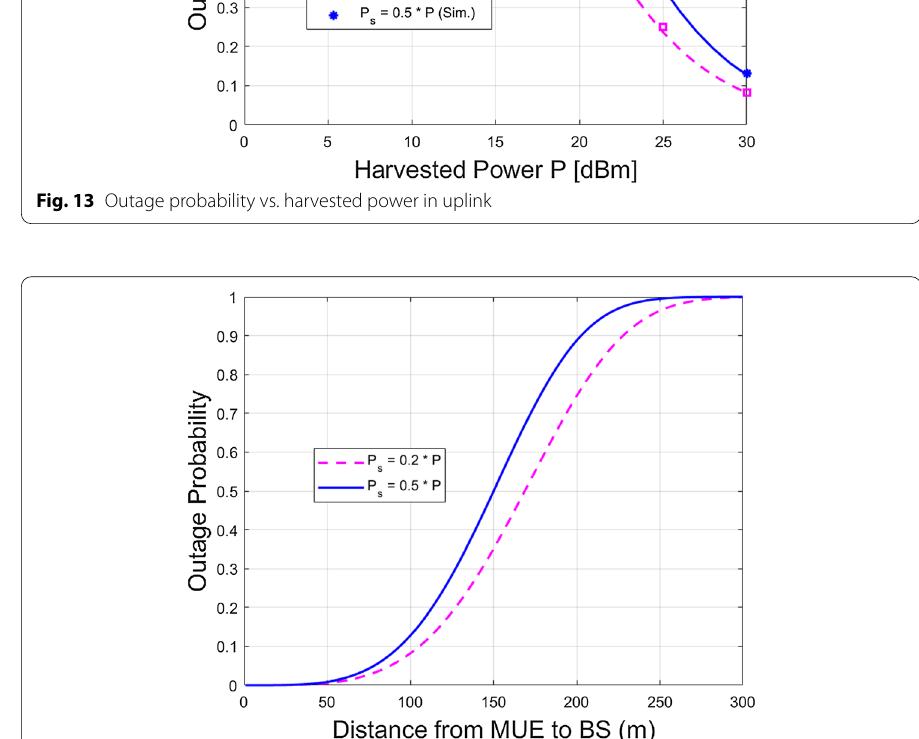
Fig. 14 Outage probability vs. distance from MUE to BS in